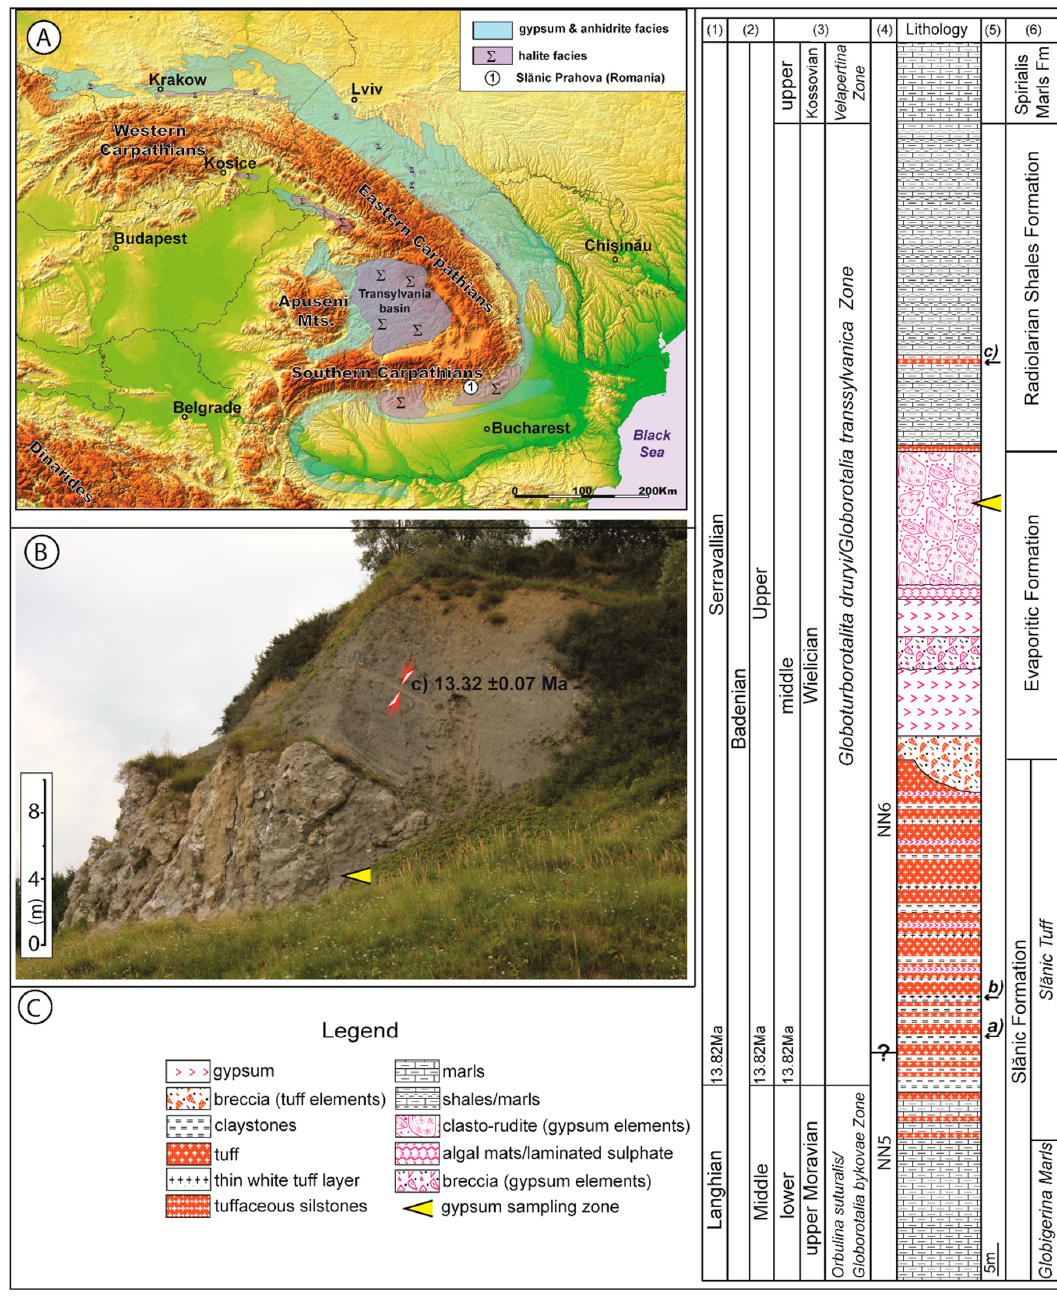
Figure 1. ( A ) Areal distribution of Late Badenian evaporitic deposits in the Carpathian area with the position of Sl ă nic-Prahova locality (Piatra Verde / Green Stone; 1); ( B ) Photo of Piatra Verde section shows the upper part of the Evaporitic Formation (yellow arrow indicates the sample position) and Radiolarian Shales and Spirialis formations (red / white arrows indicates the position of the volcanic ash layer dated at 13.32 ± 0.07 Ma by [14]; ( C ) Lithostratigraphy at the Green Stone Hill (Muntele Piatra Verde) after [2,3,11,16]. (1) Mediterranean regional stages [17]; (2) Central Paratethys regional stages [18]; (3) Substages and Forams biozonation after [5–8] (4) Calcareous Nannoplakton Zonation [19]; (5) Events: (a) Last Common Occurrence (LCO) Sphenolithus heteromorphus [11]; (b) absolute age of a white tuff layer 13.7 ± 0.26 Ma [2]; (c) absolute age of a tuff layer 13.32 ± 0.07 Ma [14]; (6) formation names for the post-tectonic cover deposits of the Tarc ă u nappe.